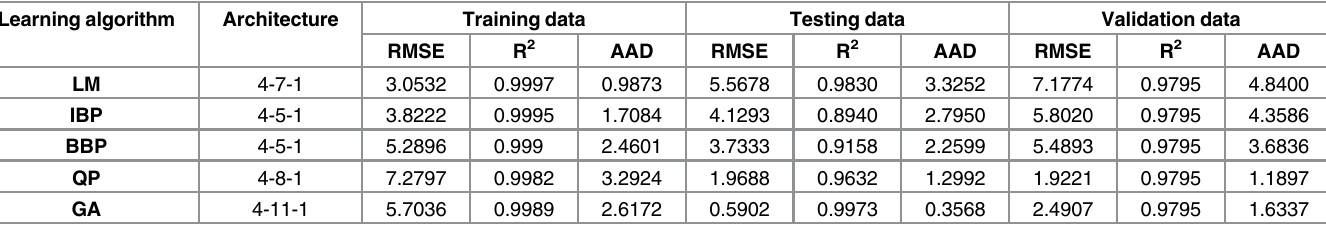
Table 4. The performance data of the optimized topologies, IBP-4-5-1, BBP-4-5-1, QP-4-8-1, GA-4-11-1, and LM-4-17-1 of the VCO nanoemulsions.